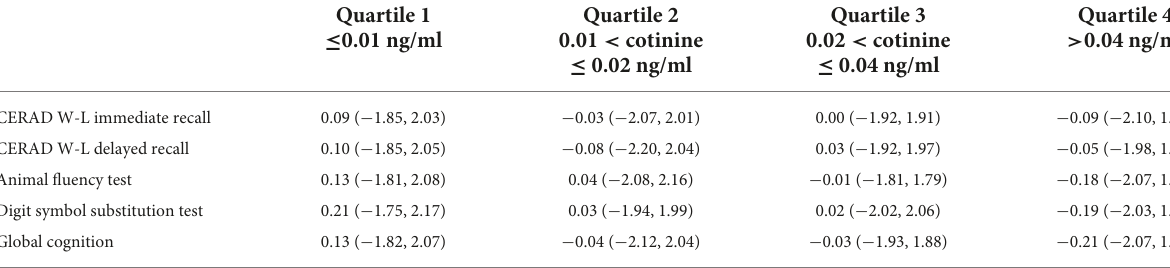
TABLE 2 Cognitive z -scores and 95% confidence intervals (CIs) by quartile of serum cotinine